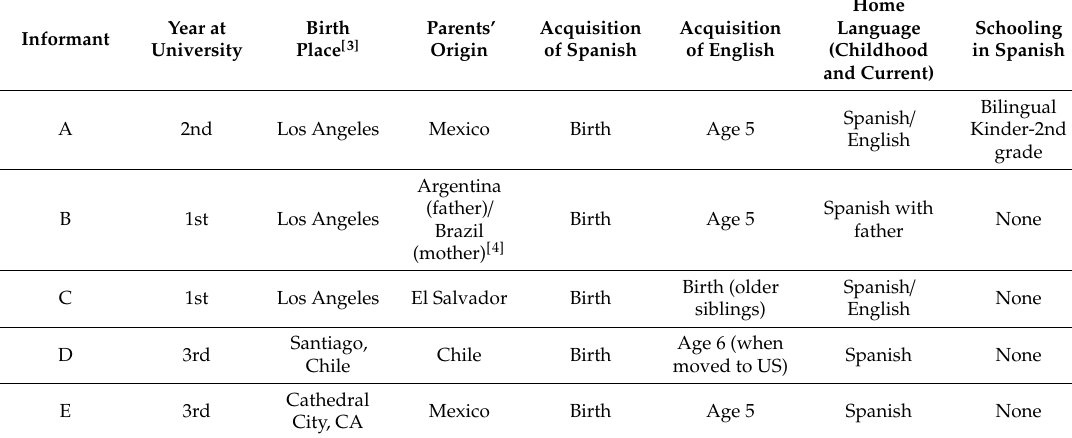
Table 2. Informant